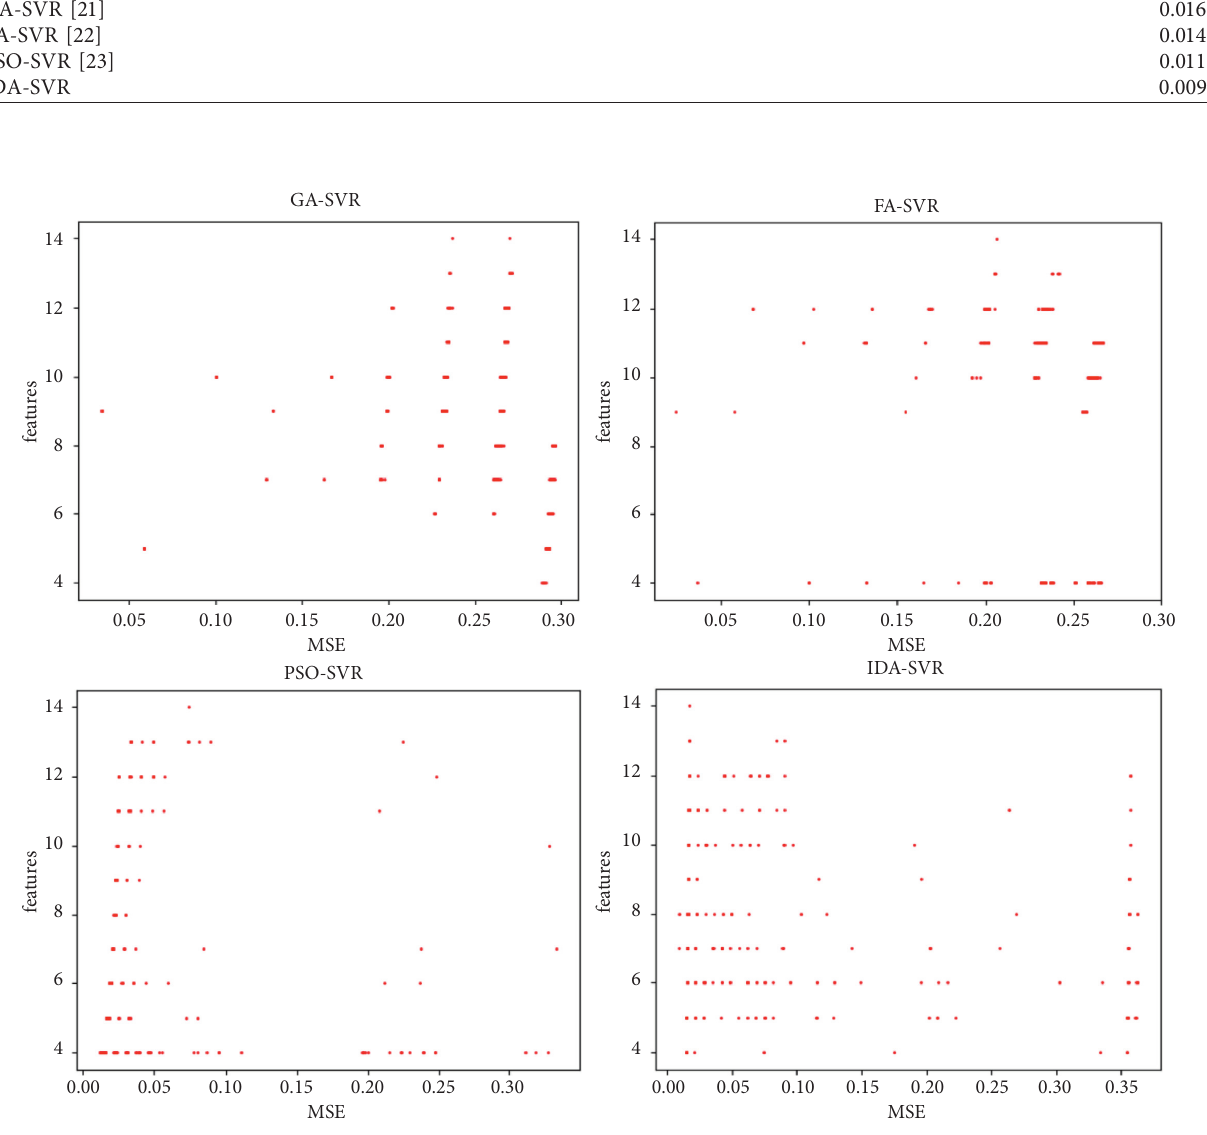
Figure 7: Running results after 500 iterations of GA-SVR, FA-SVR, PSO-SVR, and IDA-SVR.